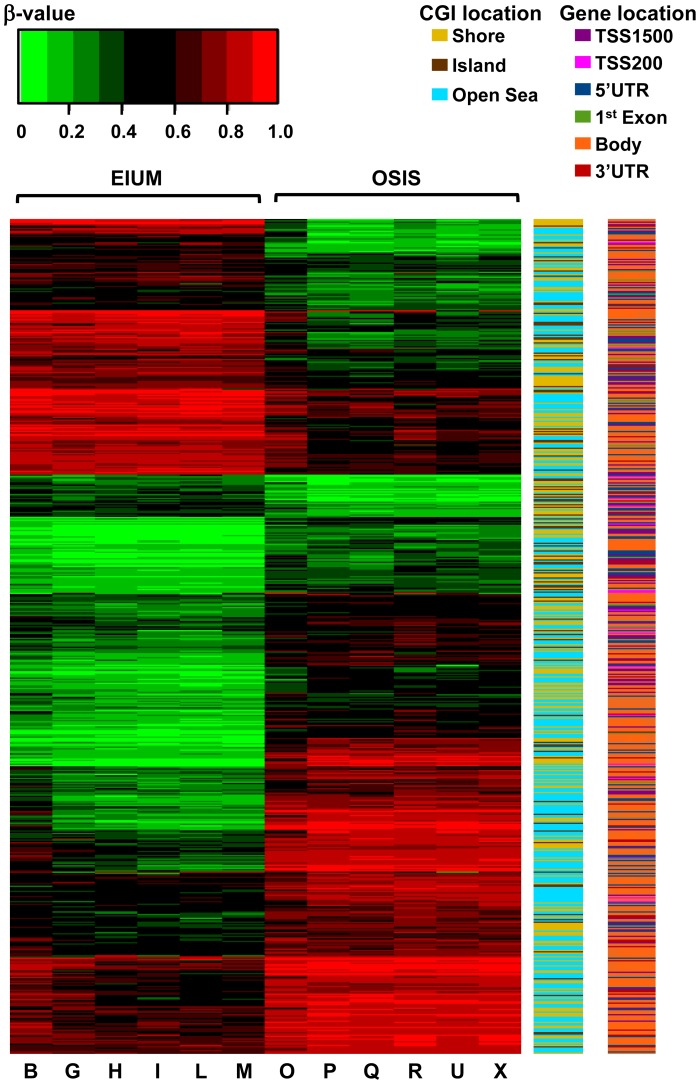
A combined heat map shows the differential methylation of the 5,423 matched CpGs in conjunction with gene and CGI context for EIUM and OSIS.Relative DNA methylation from each subject is encoded for each CpG from unmethylated (β-value = 0; green) to methylated (β-value = 1; red), and clustered based on the change in methylation. CGI and gene context are encoded in the right columns.